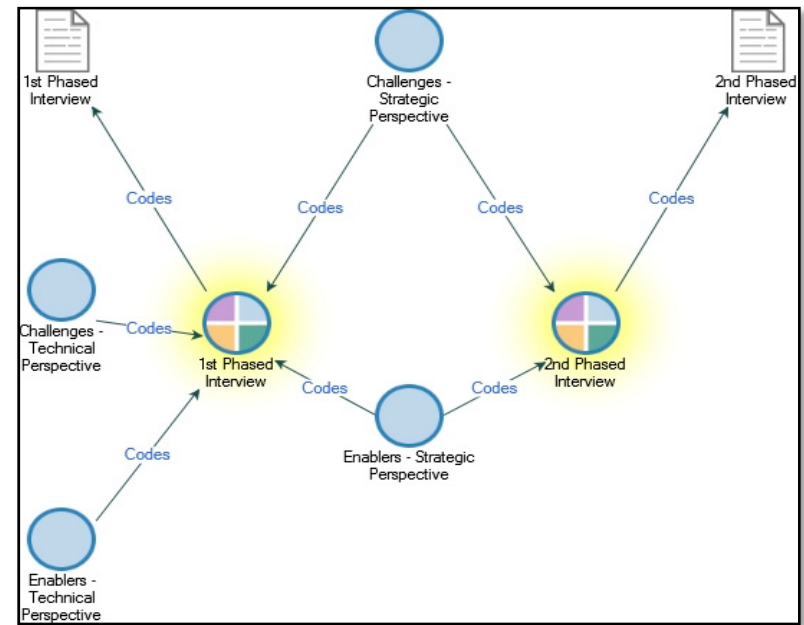
Figure 1. Semi-structured interview data coding scheme.